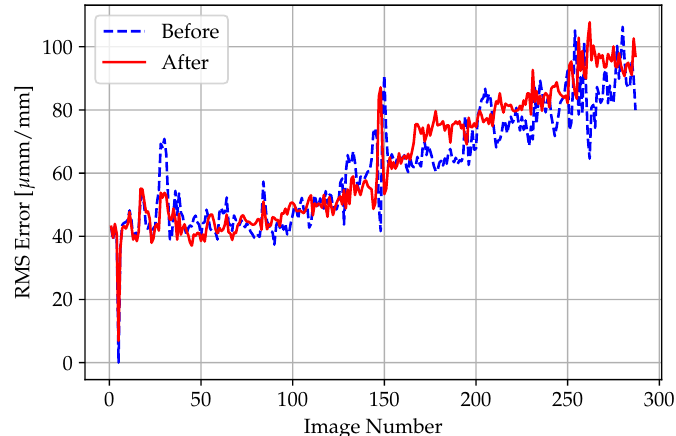
Figure 7. RMS error difference between stereo-DIC and 2D-DIC before and after correction for Test